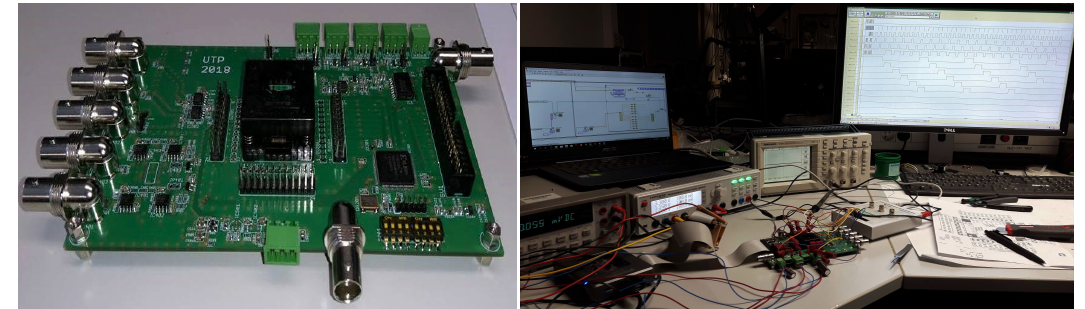
Figure 4. Measurement setup composed of PC board, designed from scratch for the verification of the realized chip prototype: ( left ) a new, printed circuit board (PCB) for the implemented integrated circuit; and ( right ) the overall measurement setup.